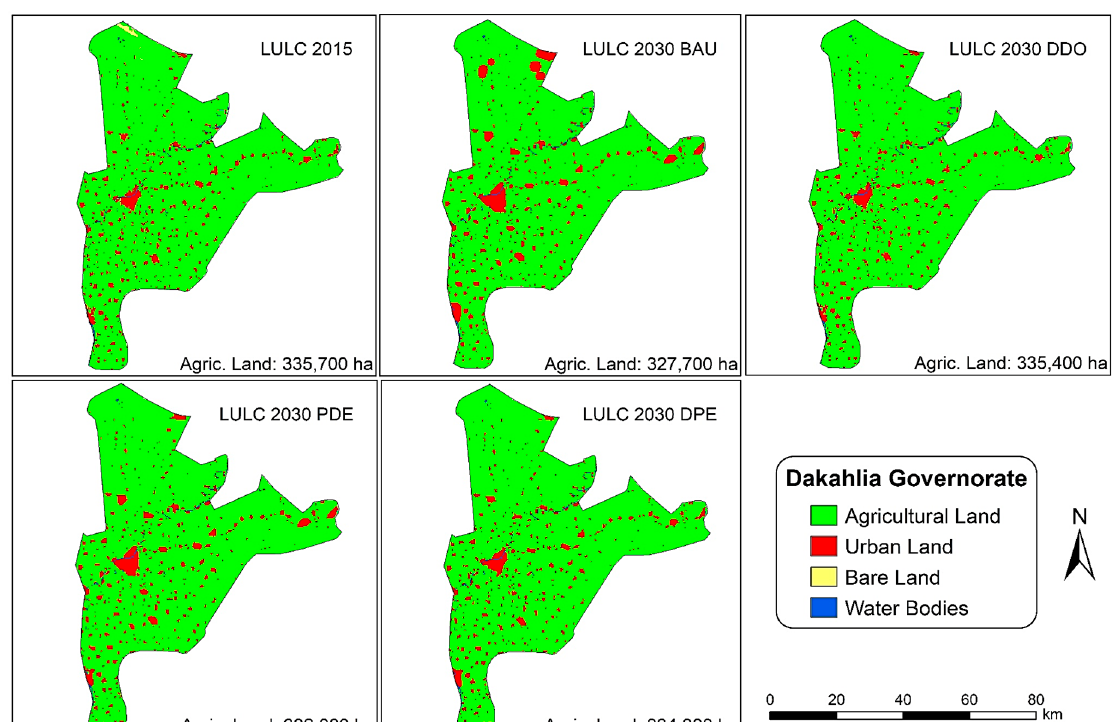
Figure A5. Amount of agricultural land over Dakahlia governorate within the simulated scenarios relative to the state in 2015.